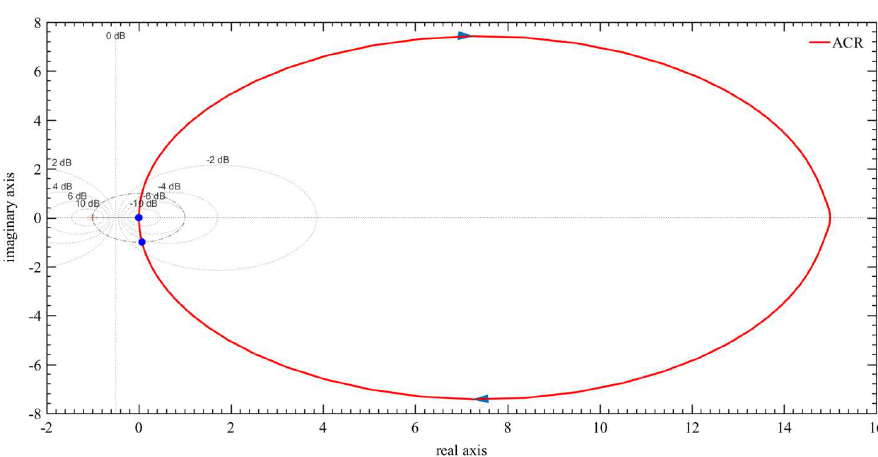
Figure 10. Root trajectory of ACR control system.